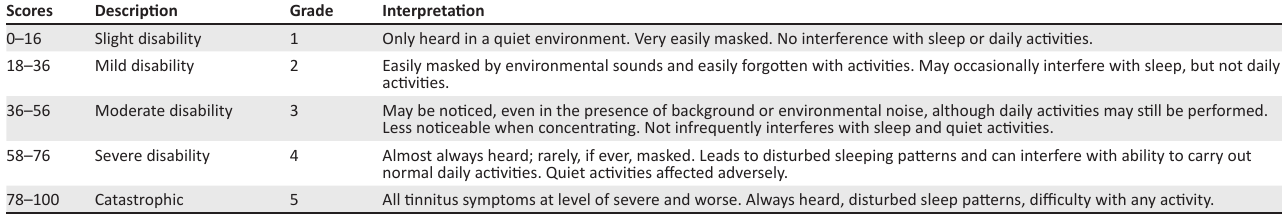
TABLE 1: Scoring the Tinnitus Handicap Inventory. Scores